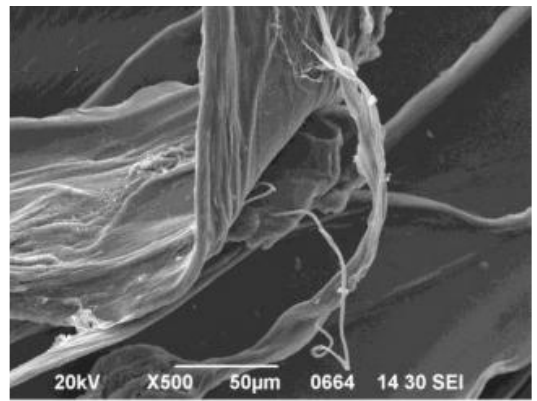
Figure 1. SEM image of GO/CAA fibers. Reprinted with permission by Elsevier [47].